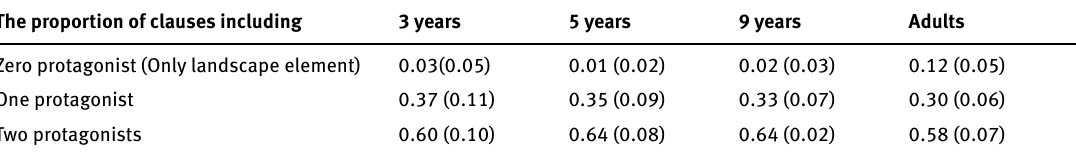
Table 4. The mean proportion and standard deviations (in parentheses) of clauses including zero, one or two protagonists. The proportion of clauses including